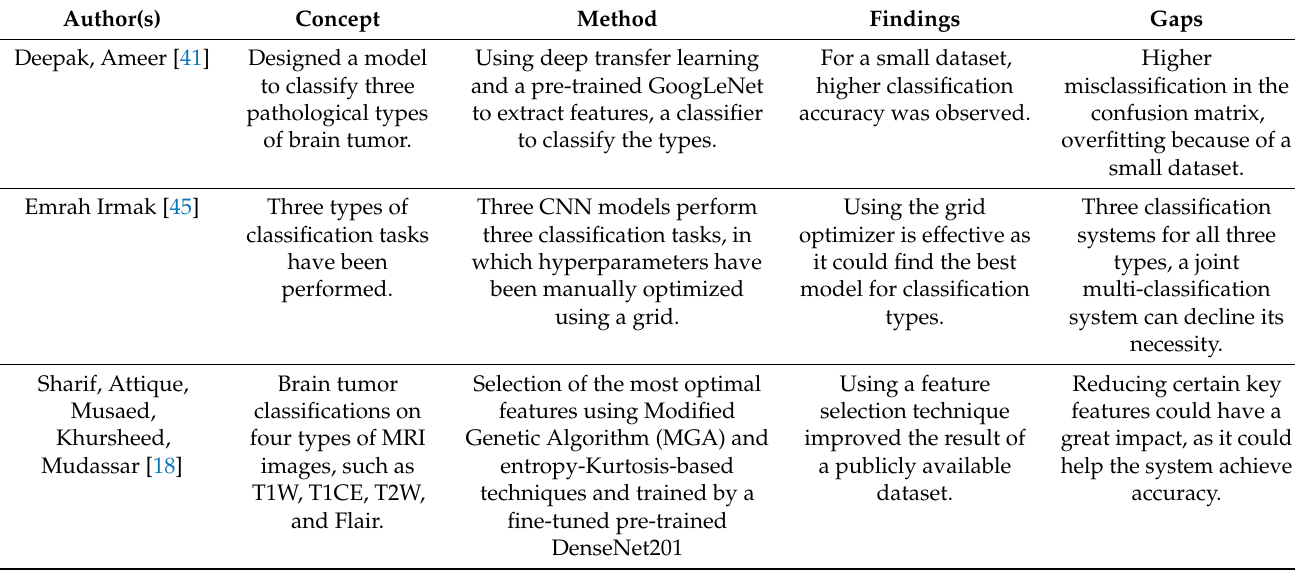
Table 1. Some other state-of-the-art work.